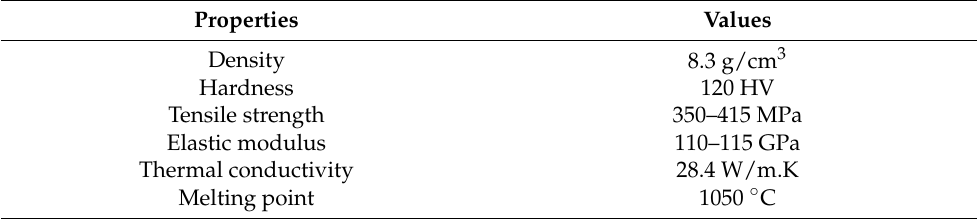
Table 2. Physical properties of C87600